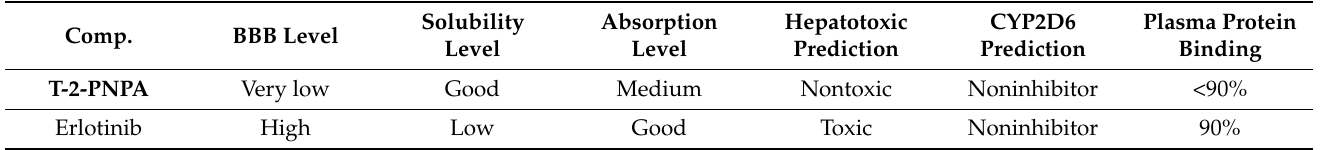
Figure 15. Computational prediction of ADMET parameters for T-2-PNPA and erlotinib. Table 3. ADMET parameters for T-2-PNPA and